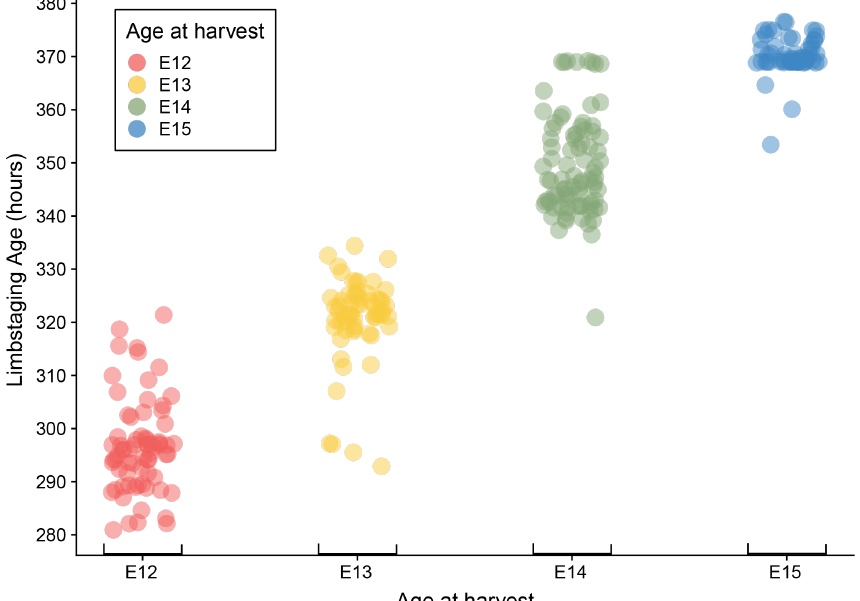
Figure 3. Plot of limbstaging age by age at harvest. Dots represent individual specimens and are colored according to age at